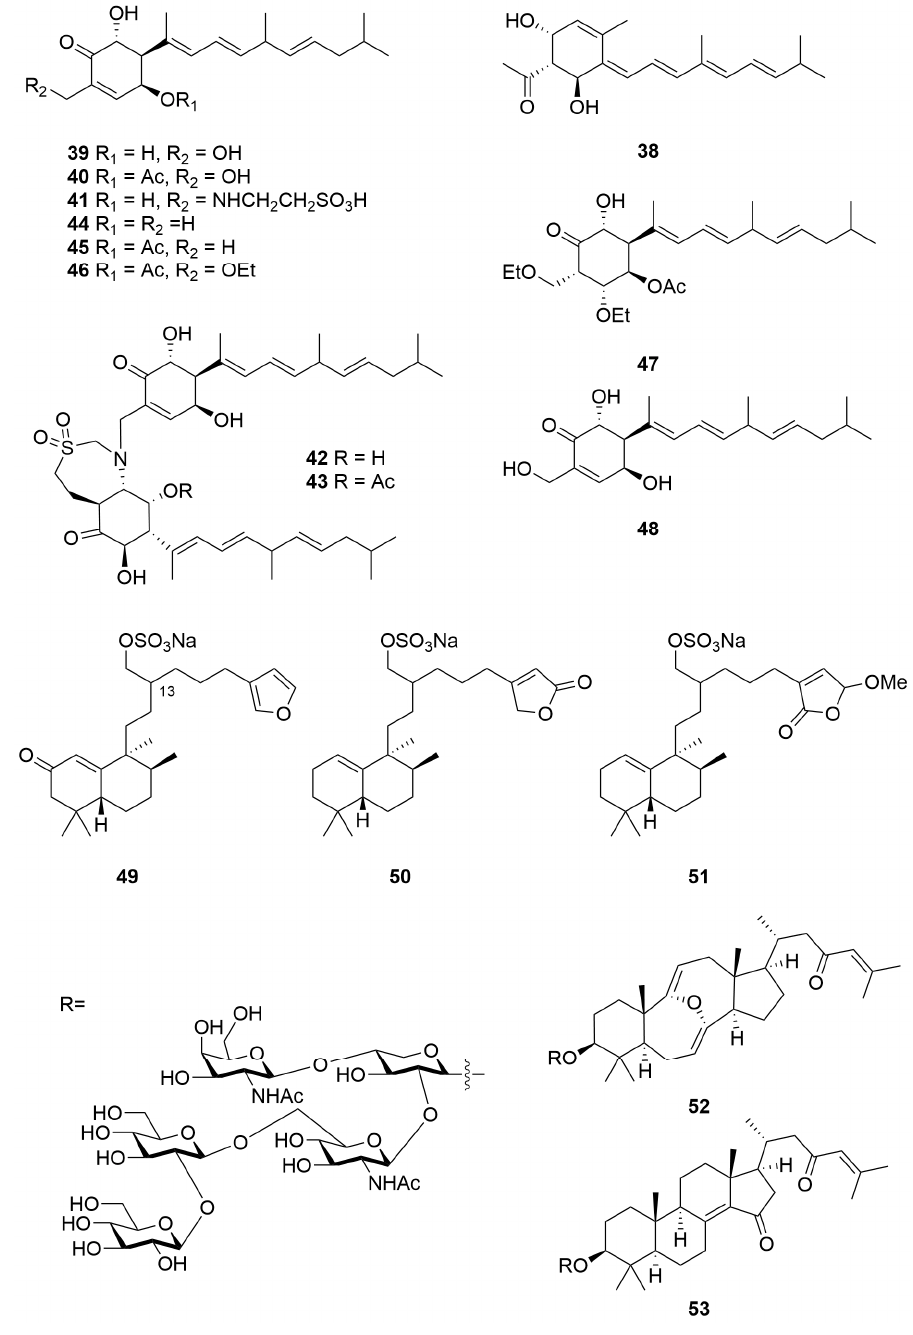
Figure 3. Compounds 38 to 53 .